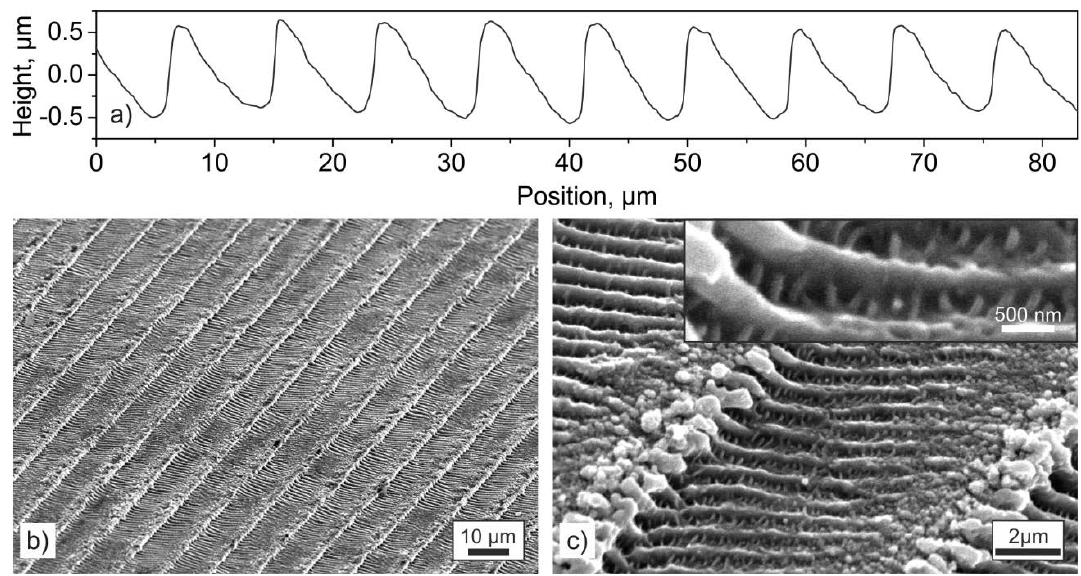
Figure 7. Profile of the structure formed by 2 beam DLIPs of substrate tilted by 45° and corresponding SEM images of the same area.